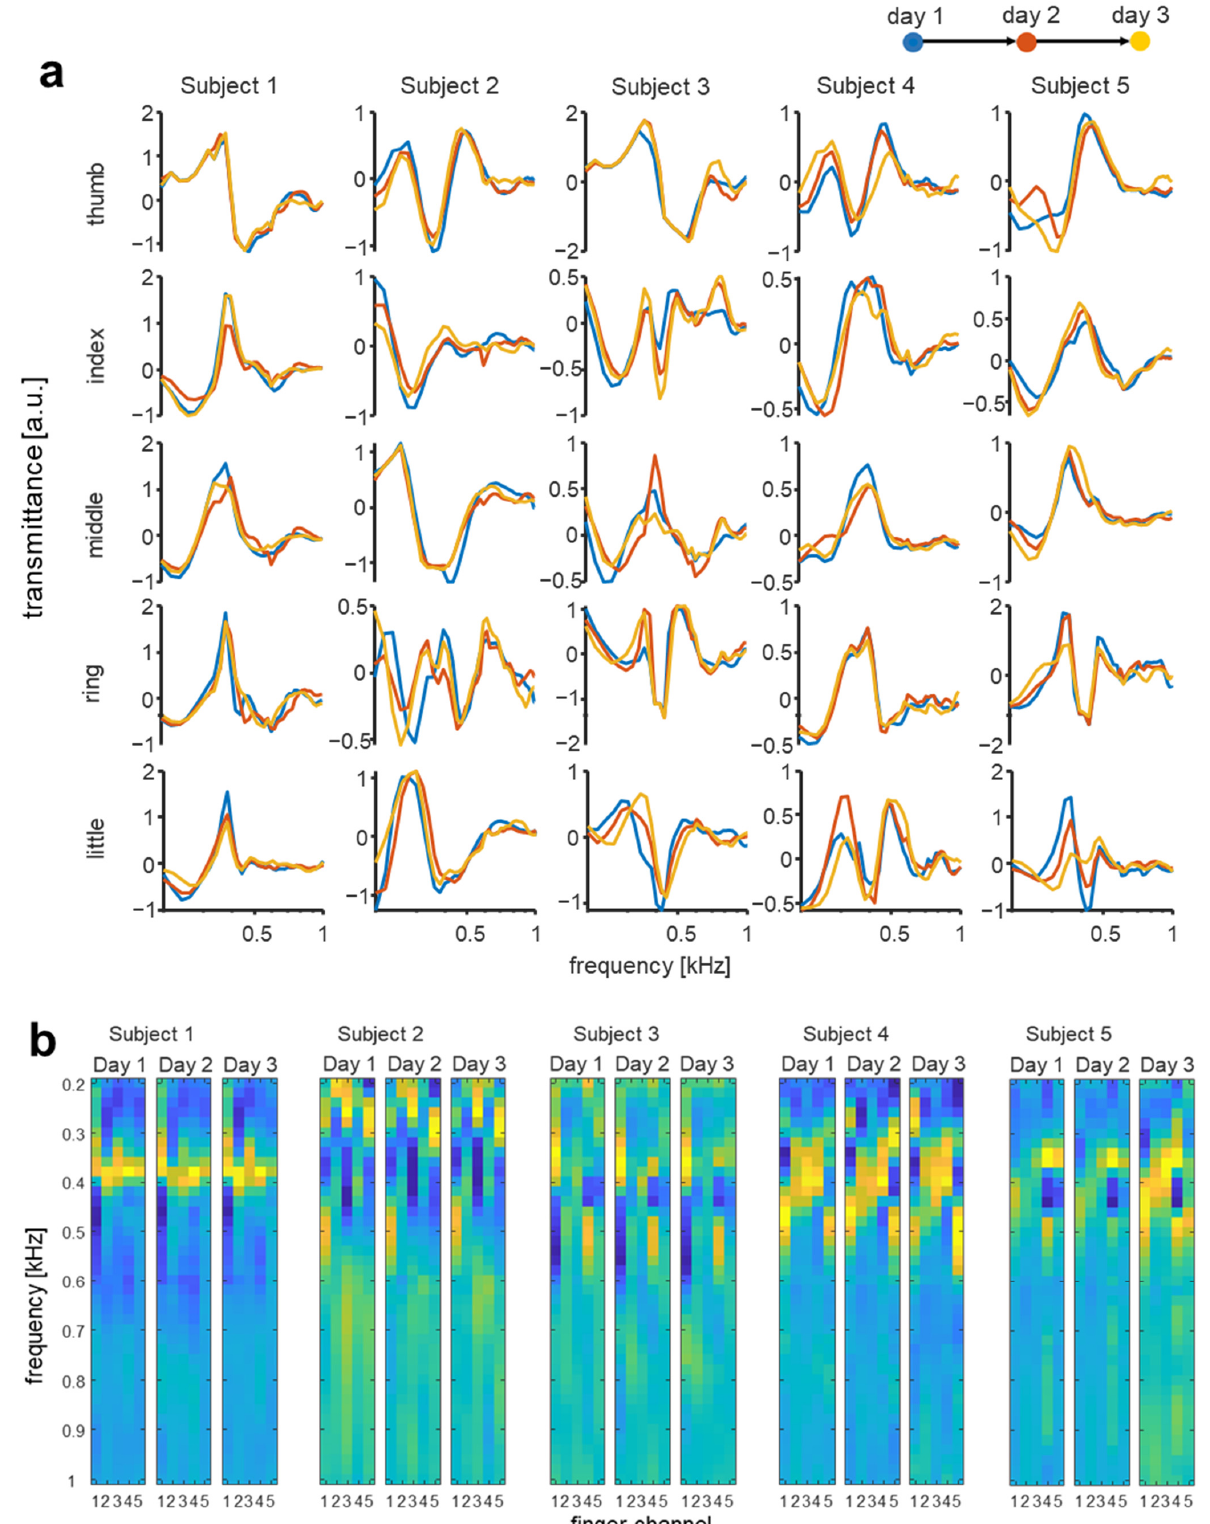
Figure 5. Temporal variation in each finger acoustic spectra in five subjects for three days. ( a ) The acoustic spectra of the fingers were measured at two-week intervals. ( b ) Two-dimensional image intensity of five-finger channel acoustic spectra of five subjects for three days.